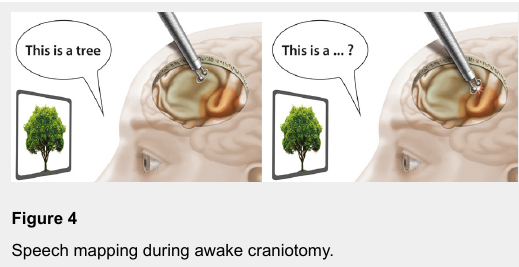
Speech mapping during awake craniotomy. Left: the patient correctly names items during electrical stimulation of non-eloquent areas and tumour tissue. Right: speech anomalies during stimulation reveal eloquent areas (brown) that need to be spared to avoid postoperative speech